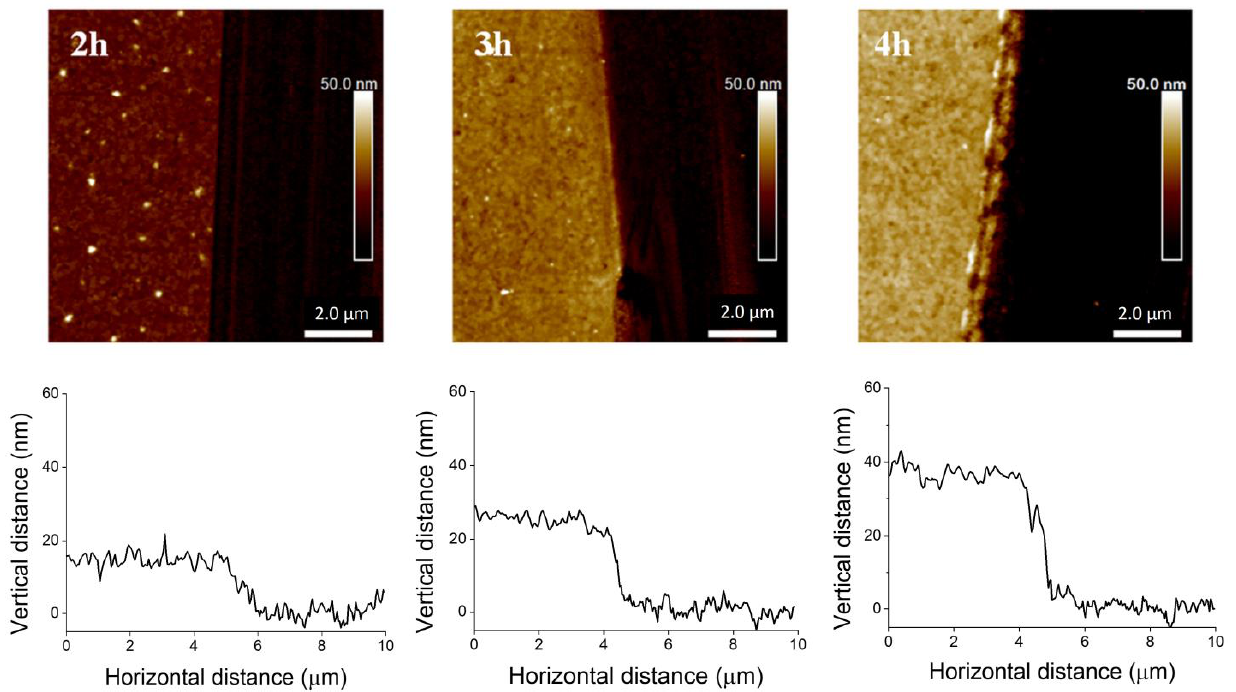
Figure 3. AFM images of ProDOT-Poly(MM) brushes and representative cross-section profiles at the edges showing their thicknesses after 2, 3, and 4 h of polymerization.